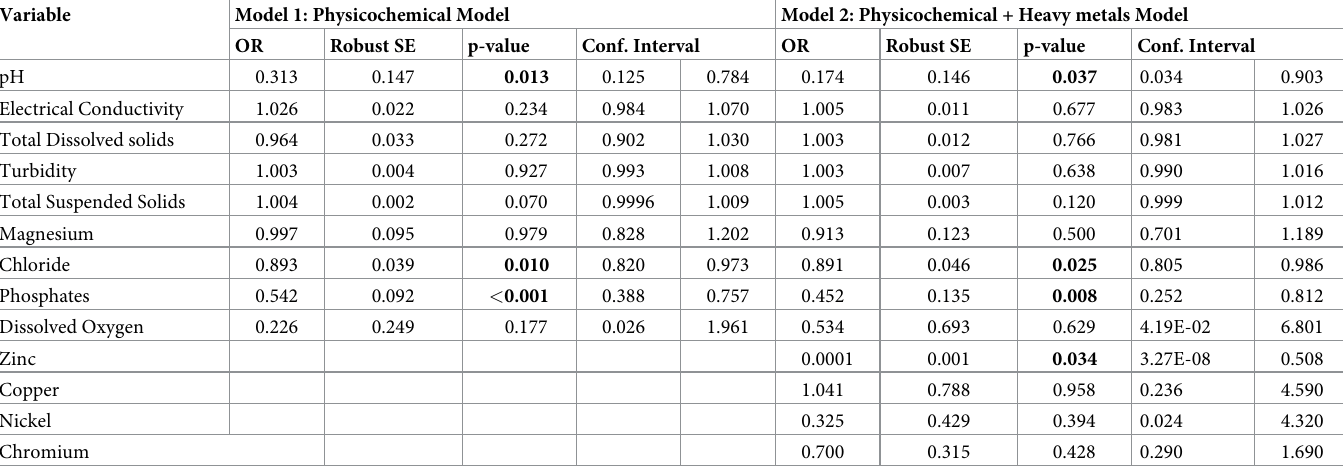
Table 5. Multivariate negative log–log regression model predicting detection of faecal coliform in surface water. Variable Model 1: Physicochemical Model